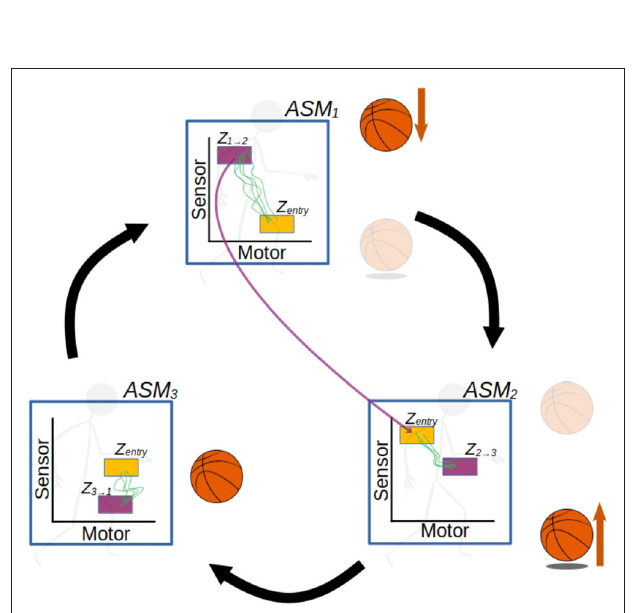
FIGURE 4 | Example of an ASM-network consisting of 10 ASM-units. Like in Figure 3 , ASM-units are represented by two-dimensional projections of sensorimotor-spaces. Arrows indicate that activation will transition from one ASM-unit to another when the controlled robot is in an appropriate sensorimotor-state. Note that the yellow initial-state regions of each ASM-unit corresponds in space with a purple or green final-state region from a preceding ASM-unit.